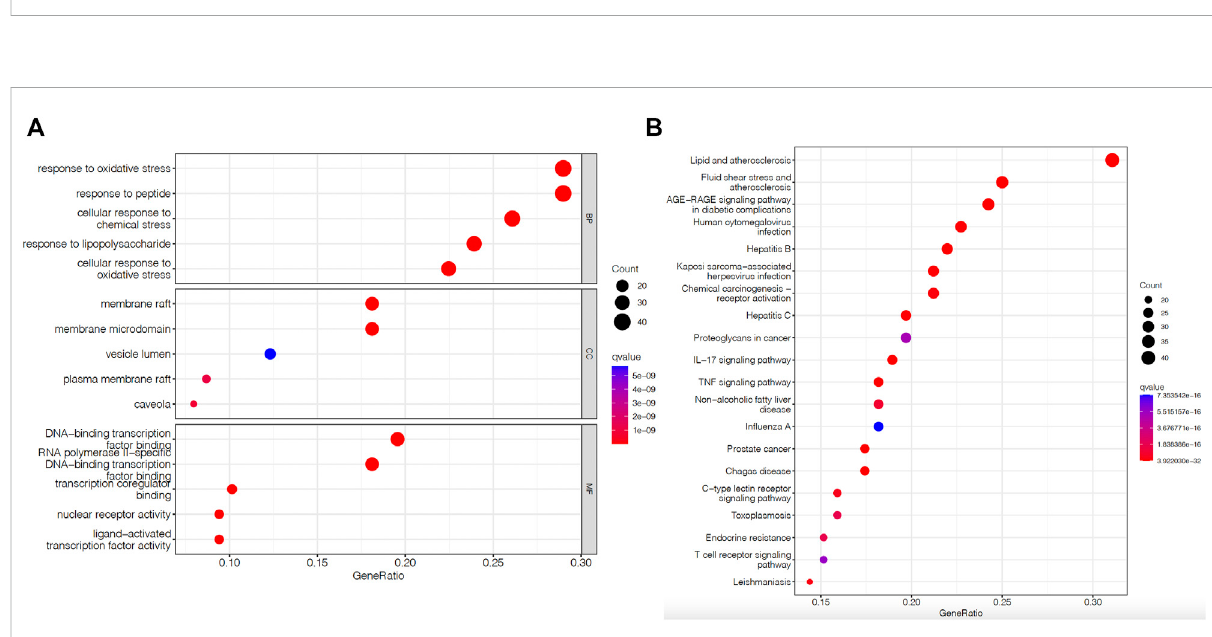
FIGURE 4 Enrichment analysis of Xuefu Zhuyu decoction in the treatment of atherosclerosis. (A) GO enrichment analysis; (B) KEGG enrichment analysis circle